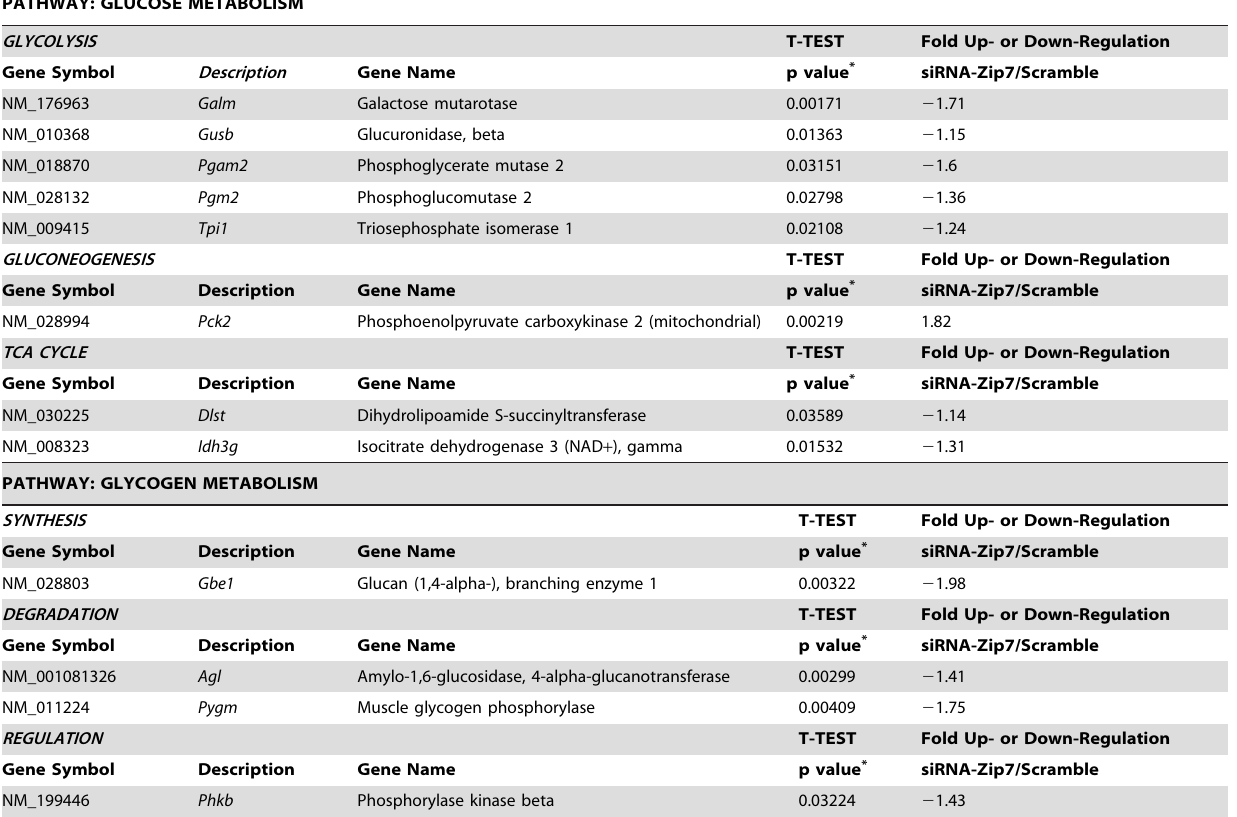
PATHWAY: GLUCOSE METABOLISM